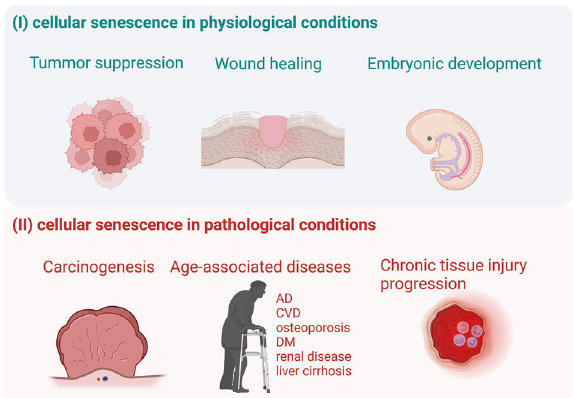
Fig. 1 Role of cellular senescence in physiology and pathology conditions. Cellular senescence plays dual roles in different conditions. In physiological conditions, cellular senescence con- tributes to tumor suppression, wound healing, and embryonic development. Cellular senescence is thought to have evolved as an antitumor mechanism where the senescence-associated secretory phenotype(SASP) recruits immune cells to facilitate senescent cells removal. In embryonic development and wound, cell-cycle arrest is induced in damaged cells and results in their elimination by macrophage. Nevertheless, in pathological conditions, senescent cells may result in carcinogenesis if they exist for a long time without clearance. Cellular senescence can also contribute to different kinds of age-associated diseases (such as Alzheimer ’ s diseases, cardiovascular diseases, osteoporosis, diabetes, renal disease, and liver cirrhosis) and chronic tissue injury